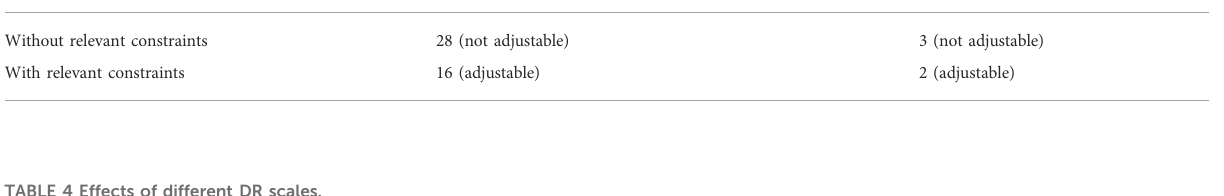
TABLE 4 Effects of different DR